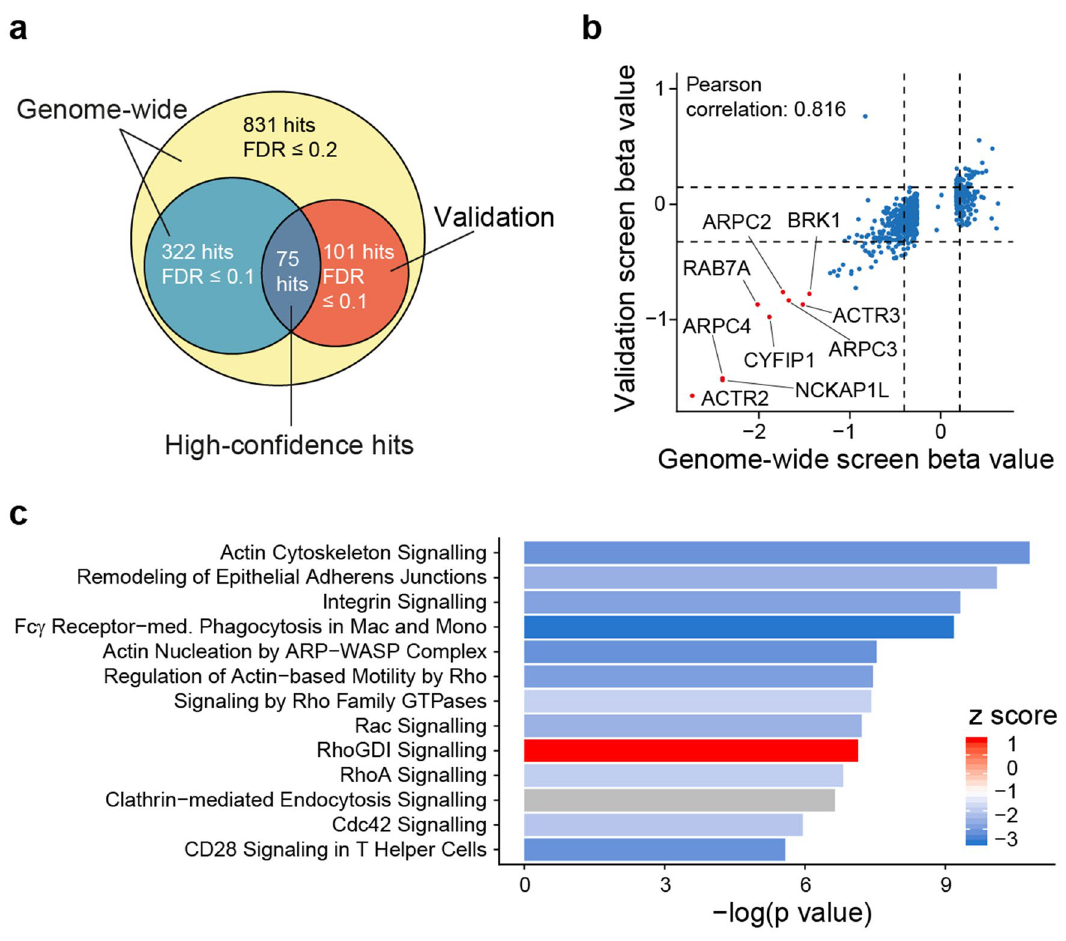
Figure 2. Comparison of both screens and secondary analysis of high confidence hits. (a) A second screen targeting a subset of genes (831 genes with FDR ≤ 0.2) was performed at very high cell-to-guide coverage (36,000×). 75 genes were detected with FDR ≤ 0.1 in both screens. One gene from the first screen showed an opposite effect in the 2nd screen and was excluded. (b) Beta values of the second screen are compared to the beta values of the first screen. ( c ) Depicted are enriched canonical pathways from IPA with − log(p values) of ≥ 5. The z score is color coded; positive and negative values indicate inhibition and activation of phagocytosis,